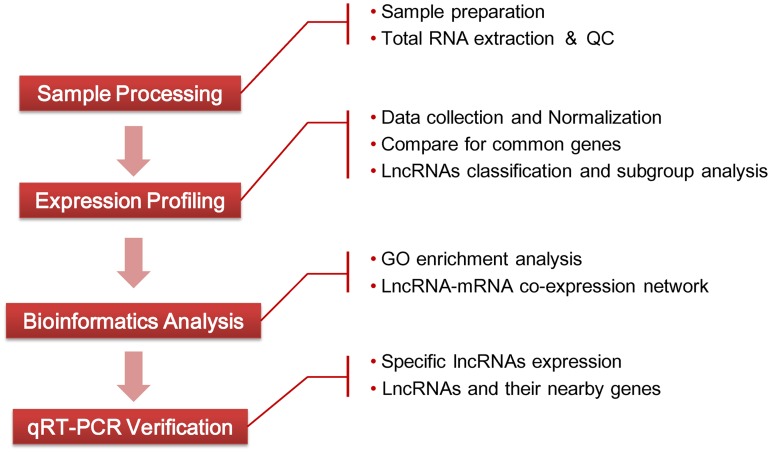
Flowchart of the experiment.